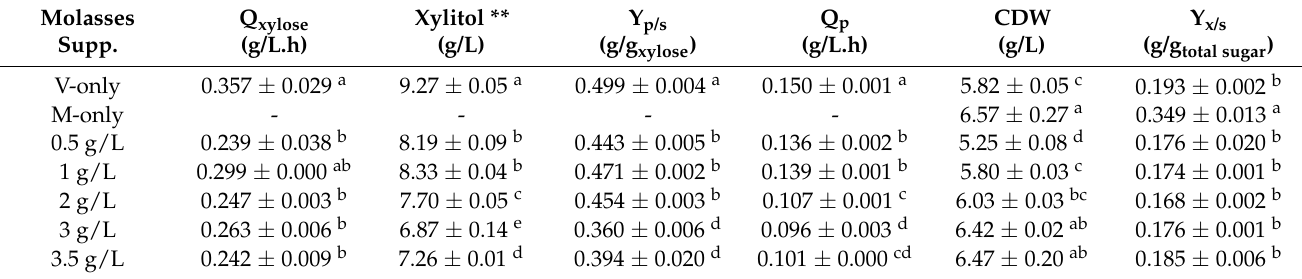
Table 3. Parameters from xylitol fermentation by C. guilliermondii supplemented by various molasse concentrations into the vinasse